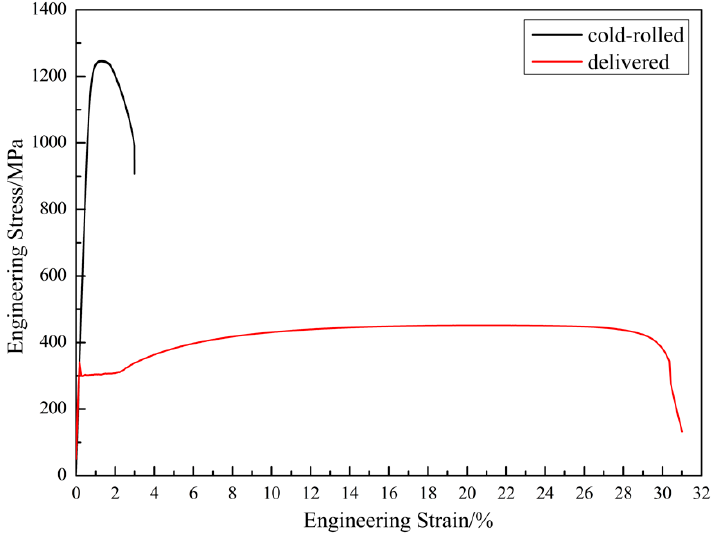
Figure 4. Engineering stress-strain curves of LH800 steel in cold-rolled and as-supplied